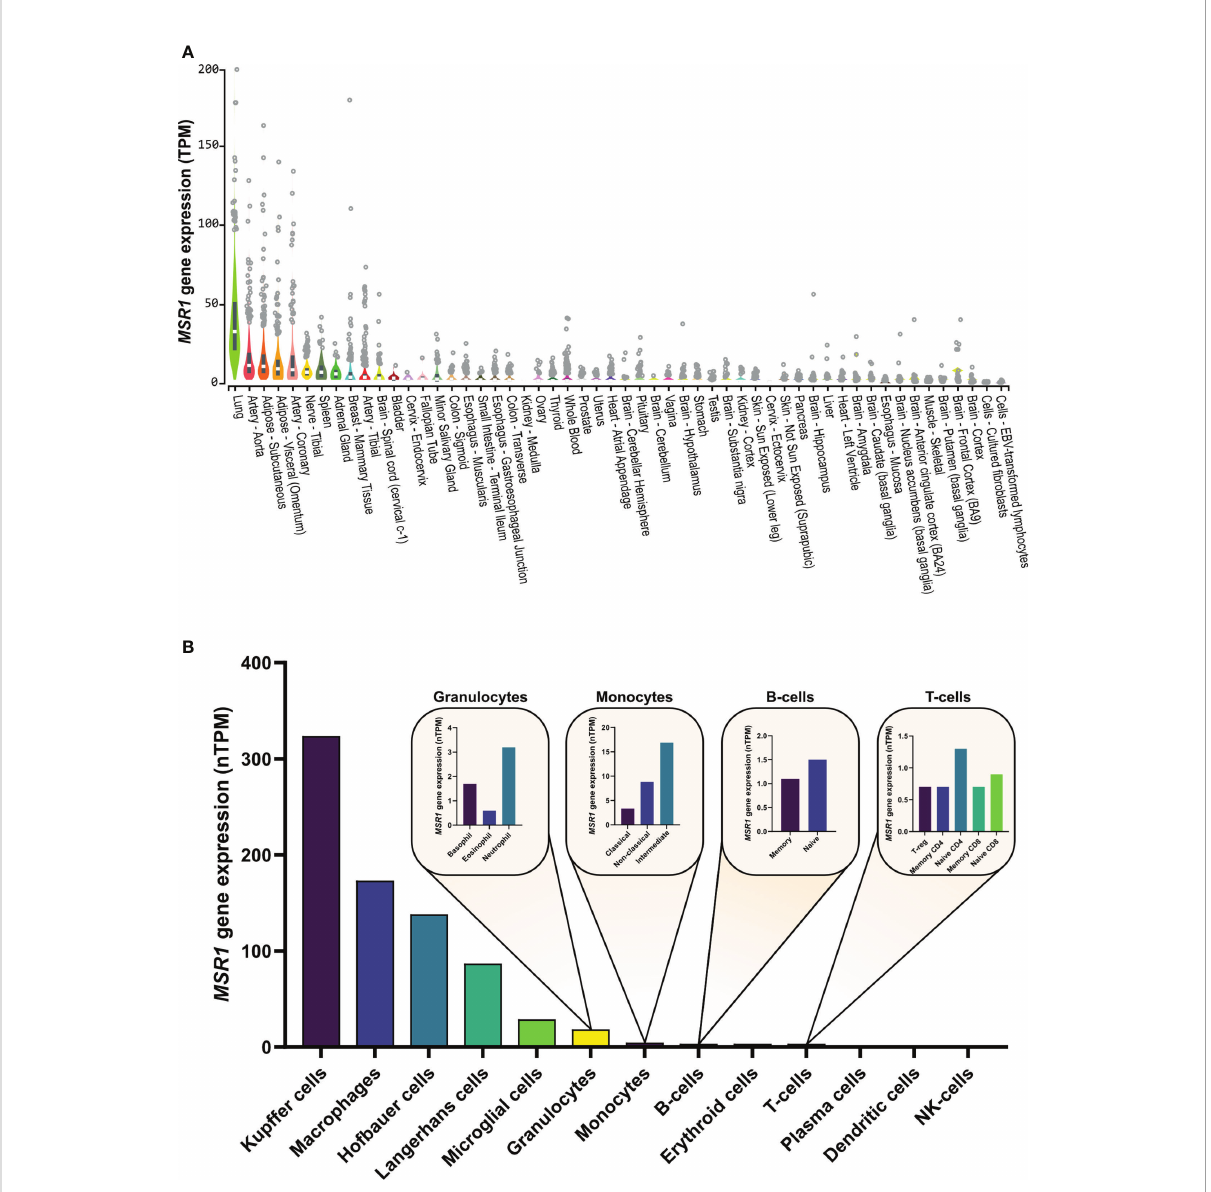
FIGURE 3 MSR1 expression in (A) normal human tissues and (B) human immune cells. Human tissue expression measured by RNA sequencing abundance of MSR1 transcripts, using a normalization method to calculate transcripts per million (TPM), determined by the GTEx Project (49). Human immune cell MSR1 expression measured by RNAseq as part of the human protein (HPA) database (proteinatlas.org)